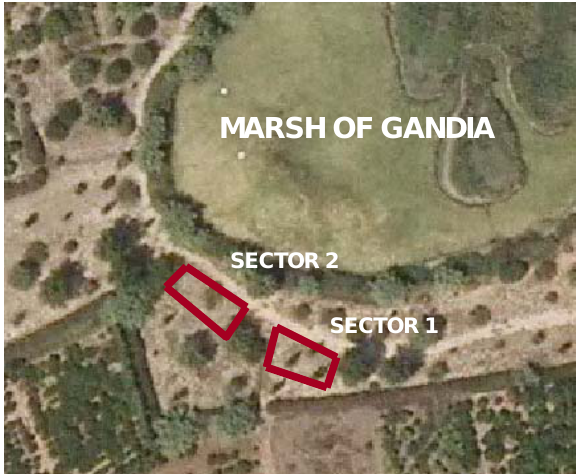
Figure 2. Survey area with the two prospected sectors. Image from Cartographical Institute of Valencia, image centre coordinates are 38º59’27” N, 0º10’45”